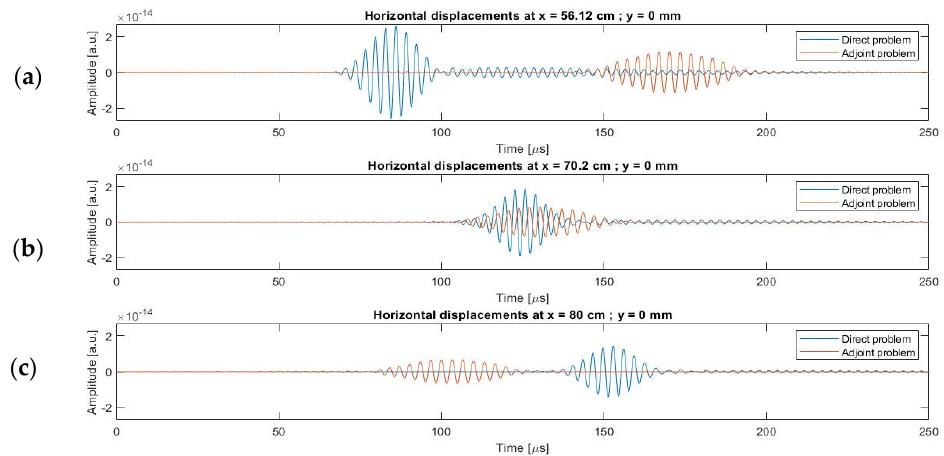
Figure 10. Horizontal displacements of the direct and adjoint problems at ( a ) x = 56.12 cm; y = 0 cm; ( b ) x = 70.2 cm; y = 0 cm; and ( c ) x = 80 cm; y = 0 cm.